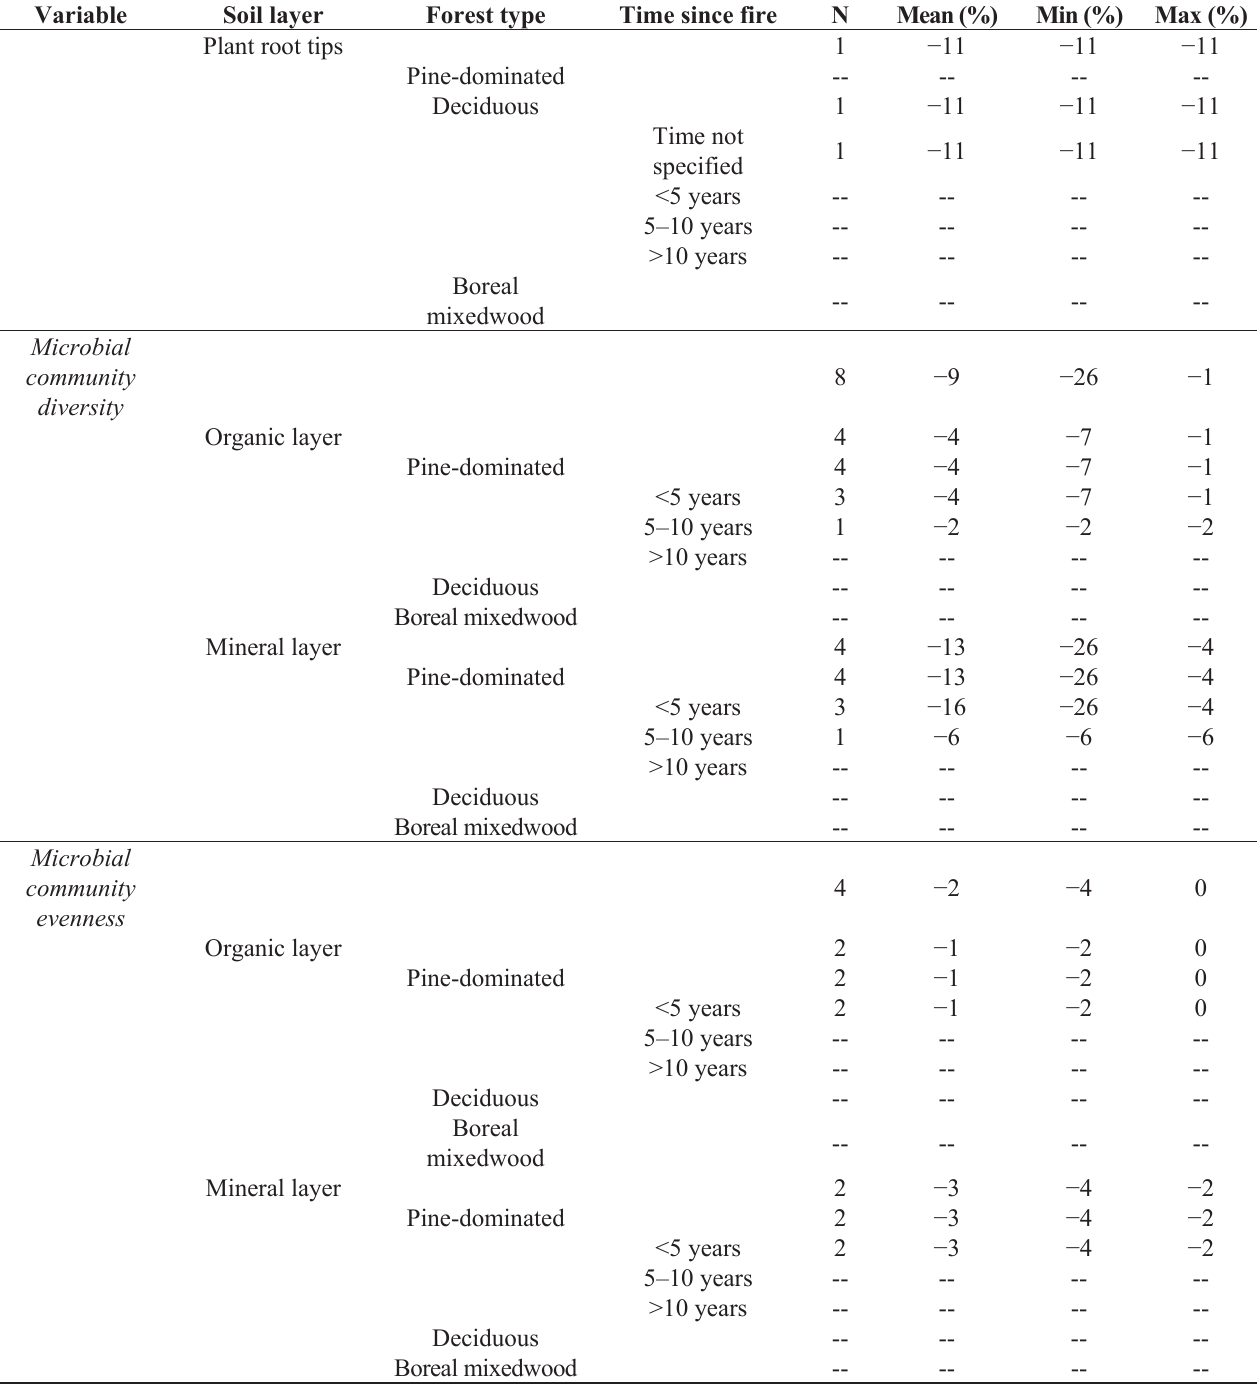
-- -- -- Boreal mixedwood -- -- -- -- 1 Indicates data reported from combined organic + mineral layers and from the organic-mineral